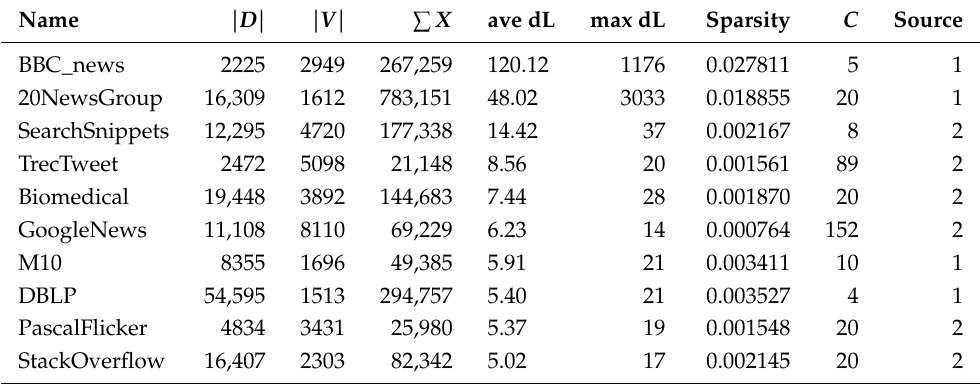
Table 2. Details of Data